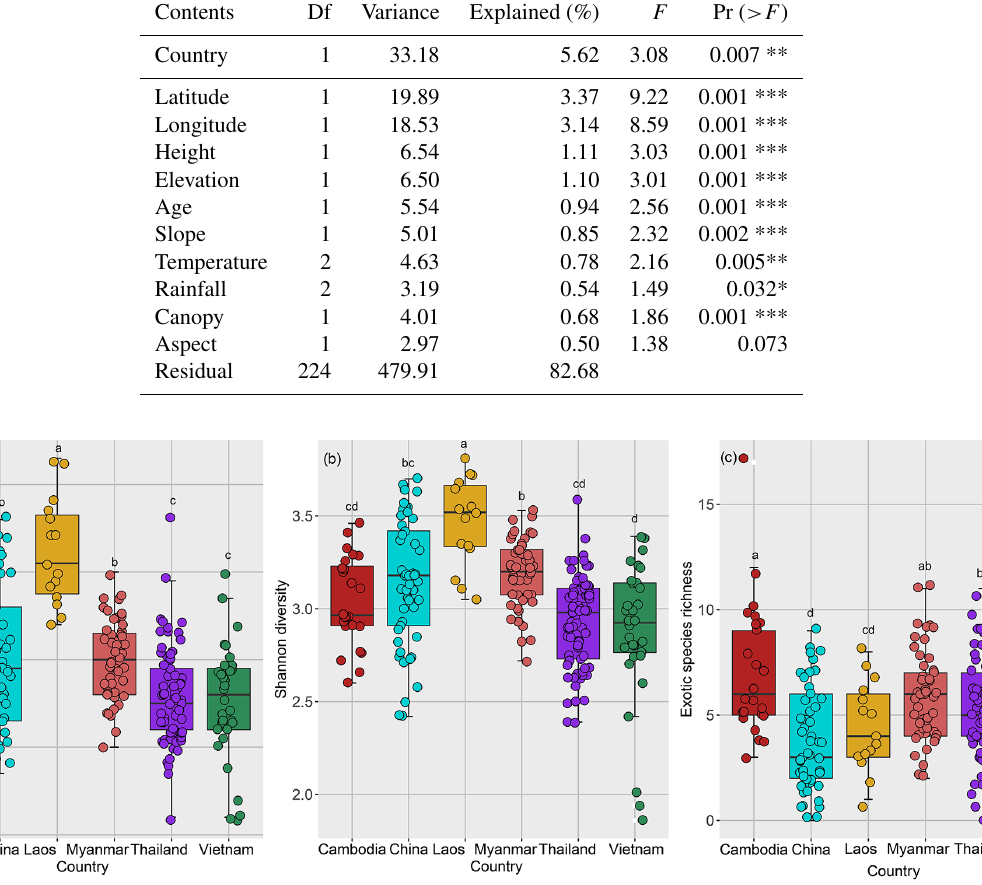
Figure 5. Plant species diversity of rubber plantations across countries in the GMS ( a : species richness; b : Shannon diversity; c : exotic species